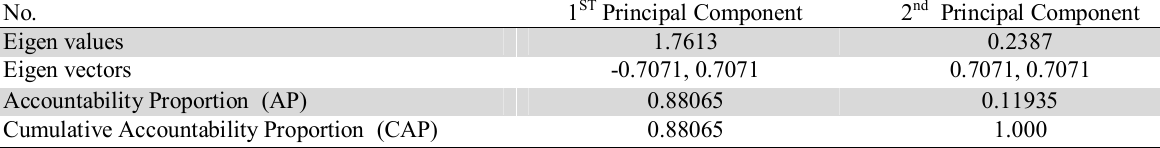
Eigen Values, Eigen Vectors and Accountability Proportion